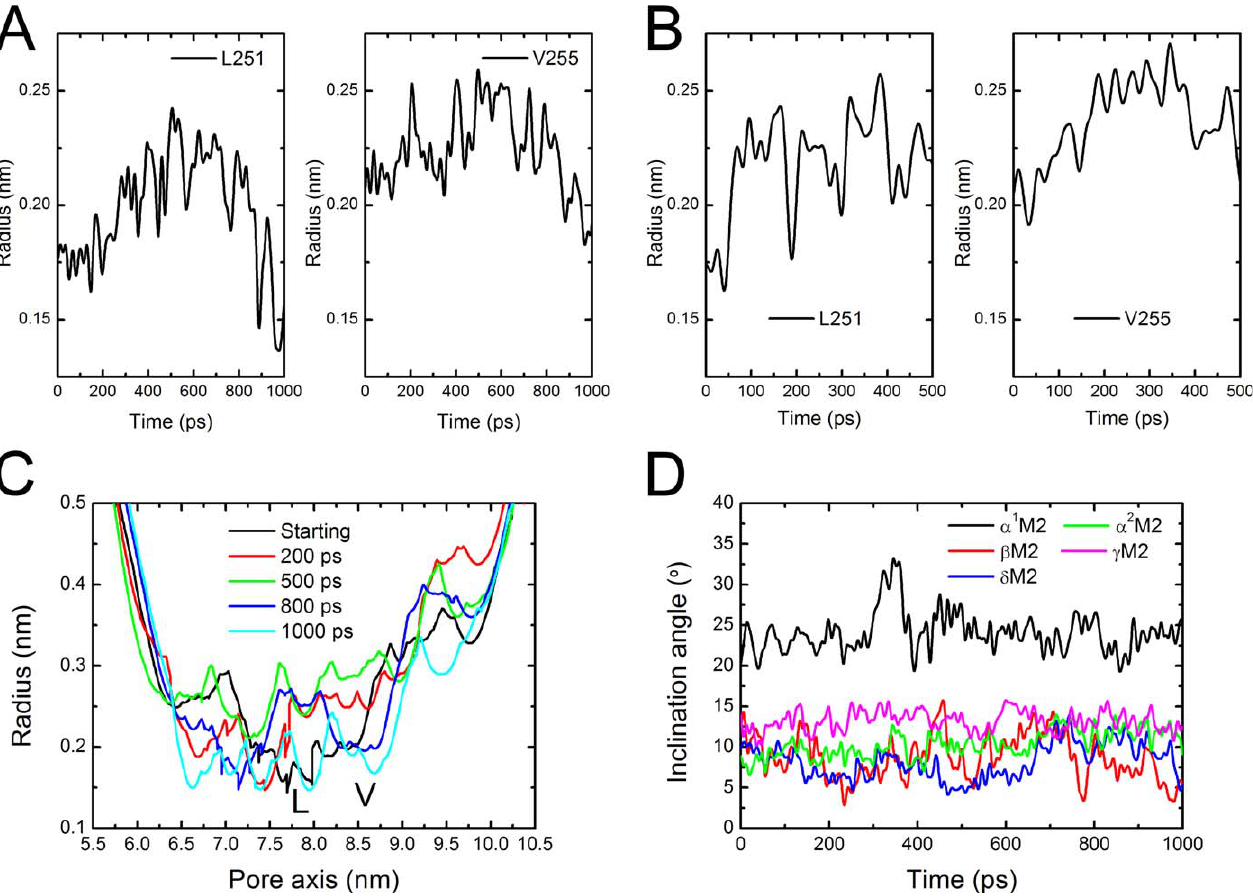
Figure 8. Dynamics of the Pore Channel Derived from the SRMD Simulations (A–B) The time-dependence of the radii of L- and V-rings as the receptor rotates in clockwise and anticlockwise directions, respectively. (C) Pore radius profiles versus position along the pore axis. Curves represent the radius changes at different time intervals for the all-atoms as the receptor rotates in clockwise direction. (D) Bending vibrations of the M2 helices represented by changes of inclination angle along the SRMD trajectory of nAChR rotating in clockwise direction. The inclination angle has been defined in Figure 2A.